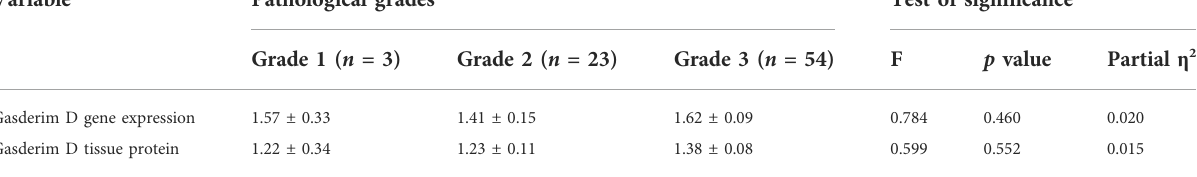
TABLE 4 Gasdermin D gene (by real-time PCR) and protein expression (by western blotting) in the bladder cancer tissue samples from the different pathological grades: Variable